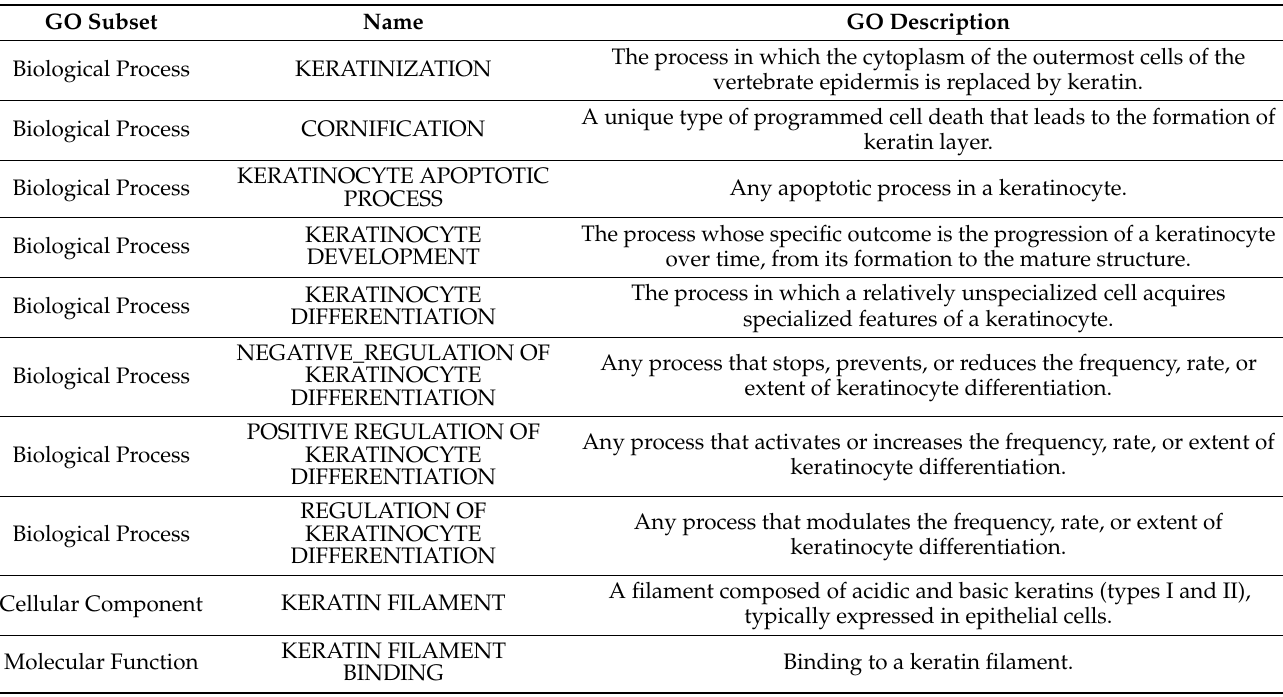
Table 1. Keratinization GO gene sets and their